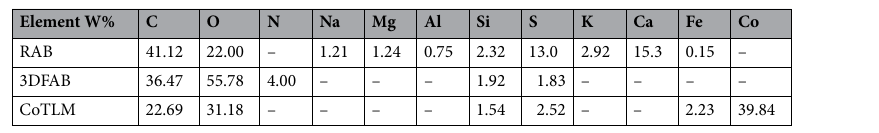
Table 1. EDS analyses of RAB, 3DFAB, and CoTLM prepared from green macroalgae.